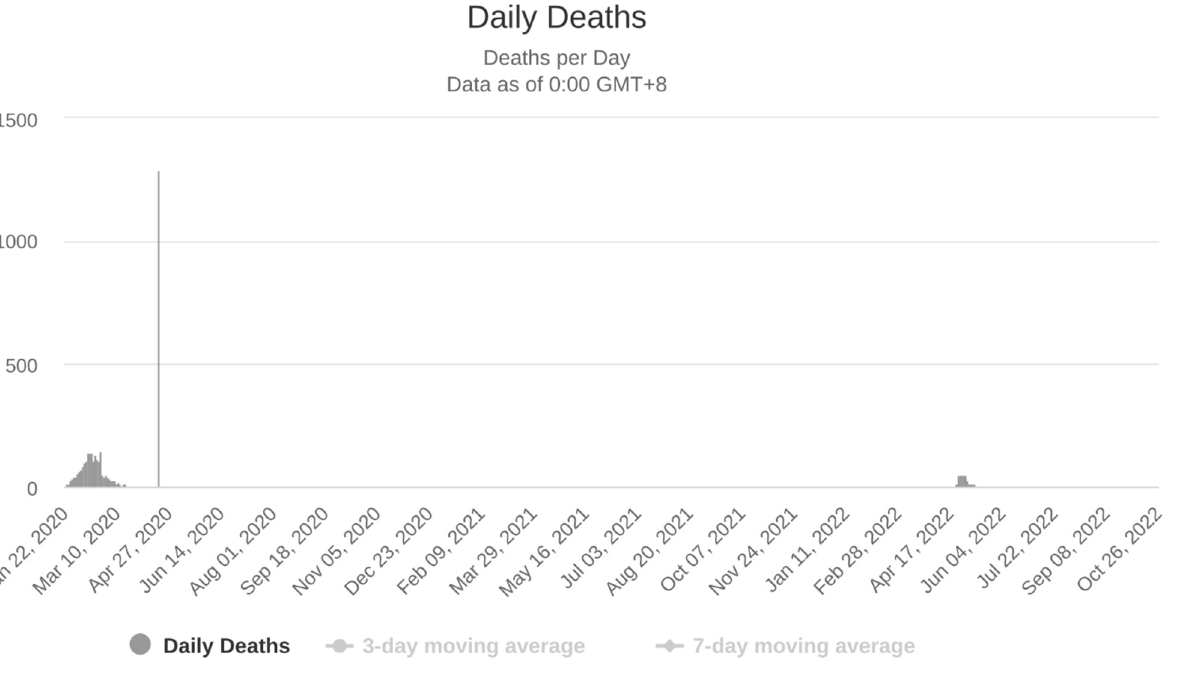
Figure 3. COVID-19 trends in deaths in China.